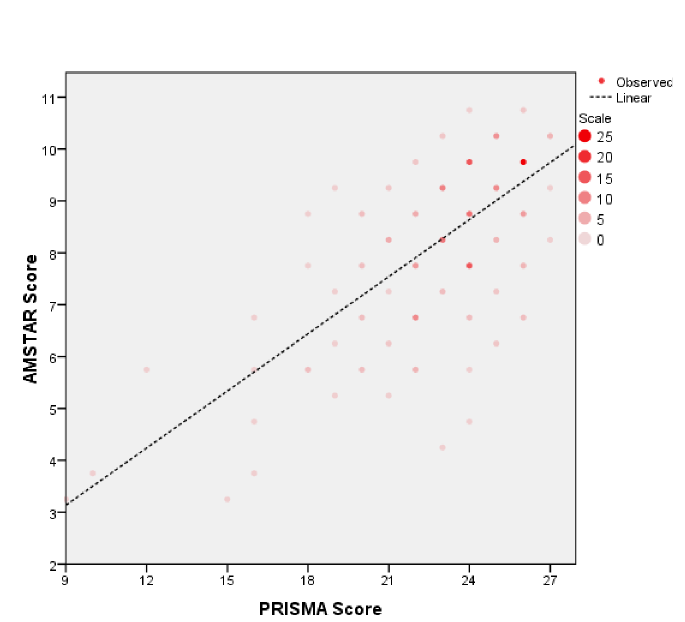
Fig 5. Forest plots of the changes in PRISMA and AMSTAR scores for factors included in univariate and multivariate regression models, along with 95% confidence intervals. A, univariate linear regression of different factors for PRISMA result, all variables were binary; B, univariate linear regression of different factors for AMSTAR result, all variables were binary; C, results of multivariate regression. Factors with P < 0.25 in univariate analysis were entered into multivariate analysis. After adjustment, only one variable was significantly associated with the PRISMA result; D, results of multivariate regression. Factors with P < 0.25 in univariate analysis were entered into multivariate analysis. After adjustment, only one variable was significantly associated with the AMSTAR result.